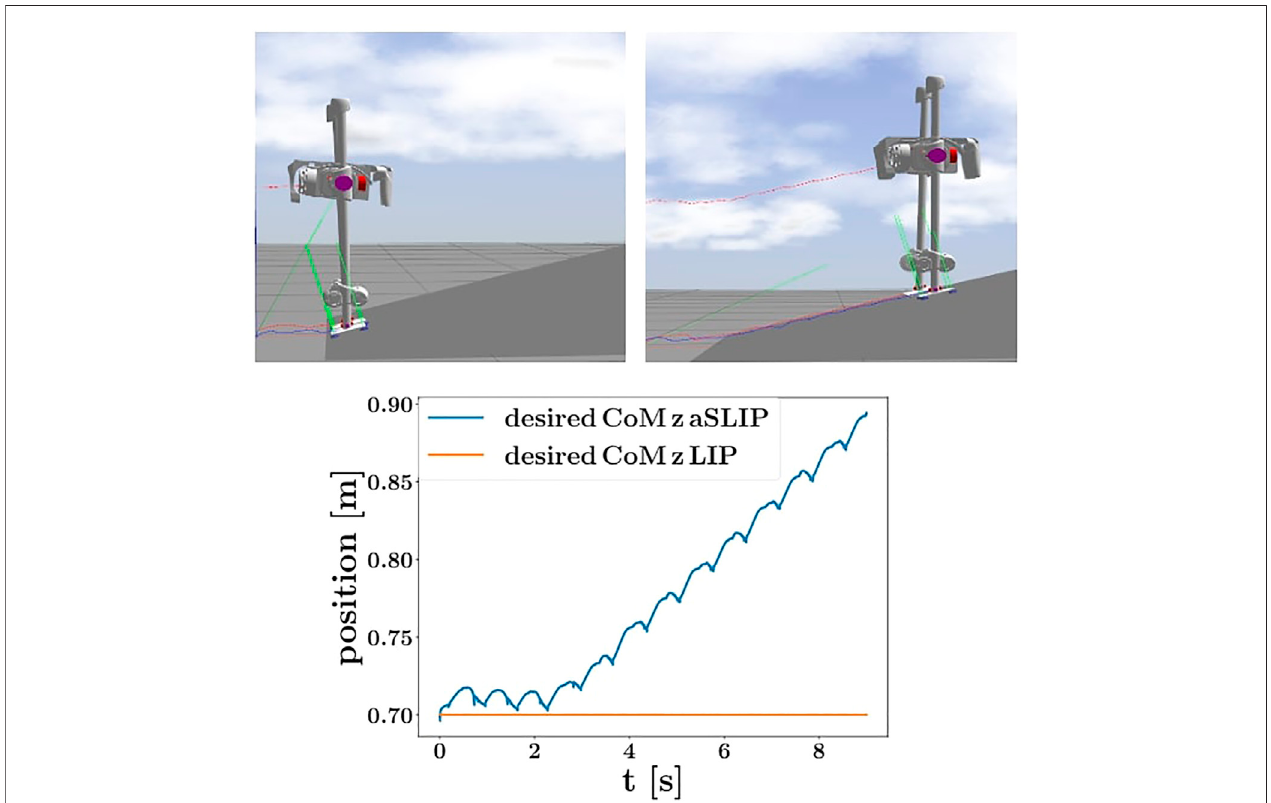
FIGURE 9 | Plots showing the states of CoM when the robot got pushed in x or y direction while walking on a wave fi eld at a speed of 0.3 m/s. The pushes are indicated with circles. All impulses are applied with a value of 40 N for a duration of 0.1 s. Top row: states of CoM when got pushed in x direction. Bottom row: states of CoM when got pushed in y